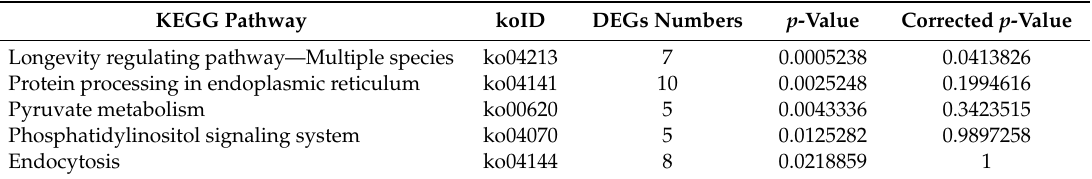
Table 2. KEGG pathway enrichment of the top 5.